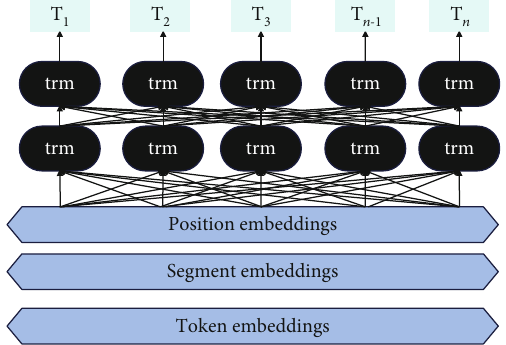
Figure 6: BERT model